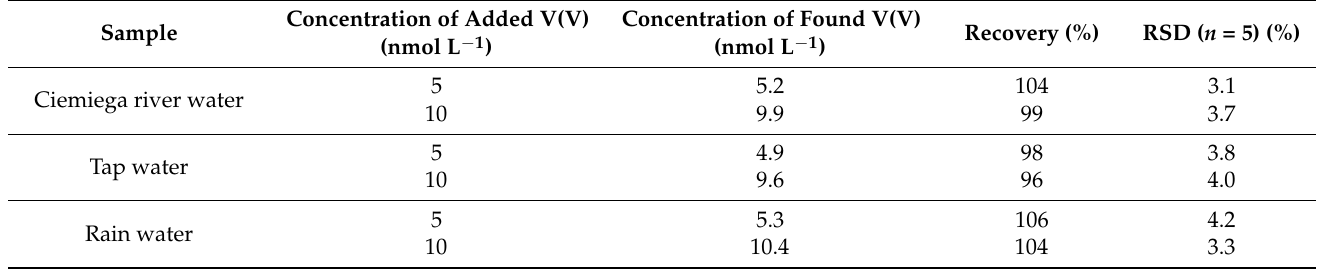
Table 3. Salvage values of V(V) obtained from spiked real water samples using the AdSV